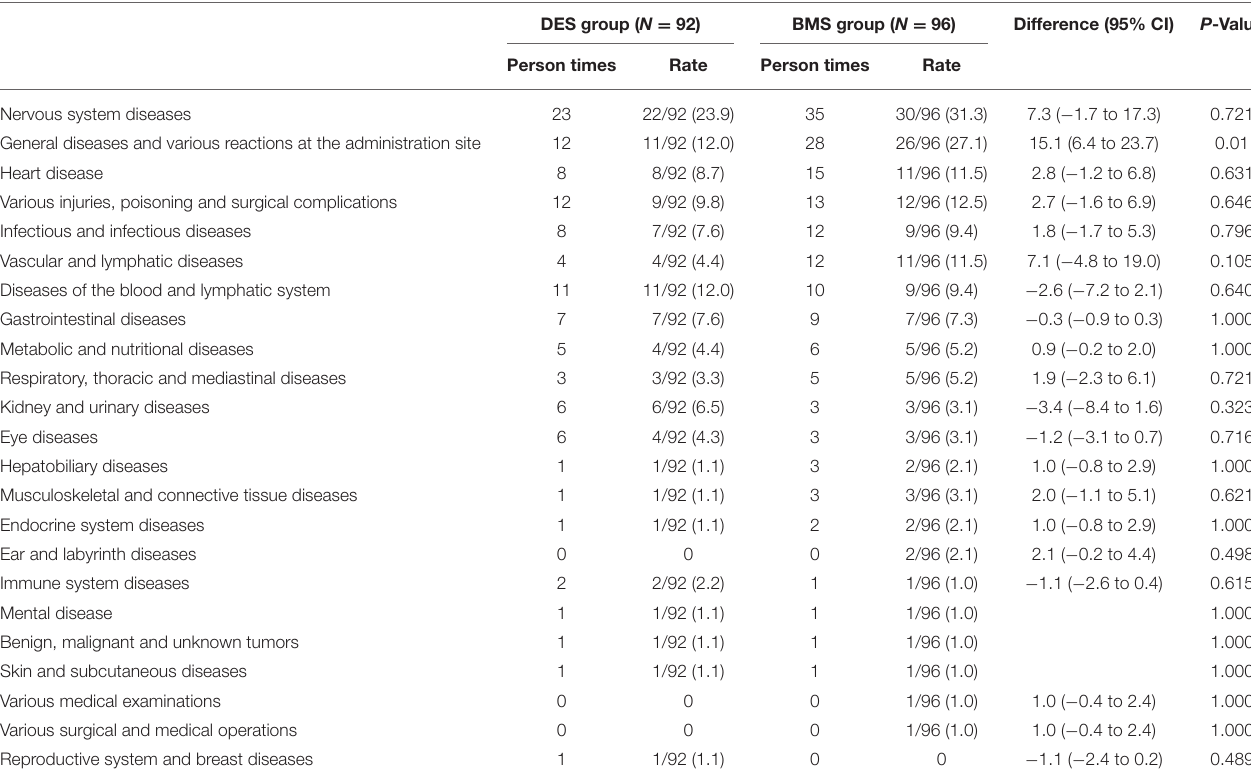
TABLE 4 | The different diseases and medical codes in the adverse event record. DES group ( N = 92) BMS group ( N = 96) Difference (95% CI) P -Value Person times